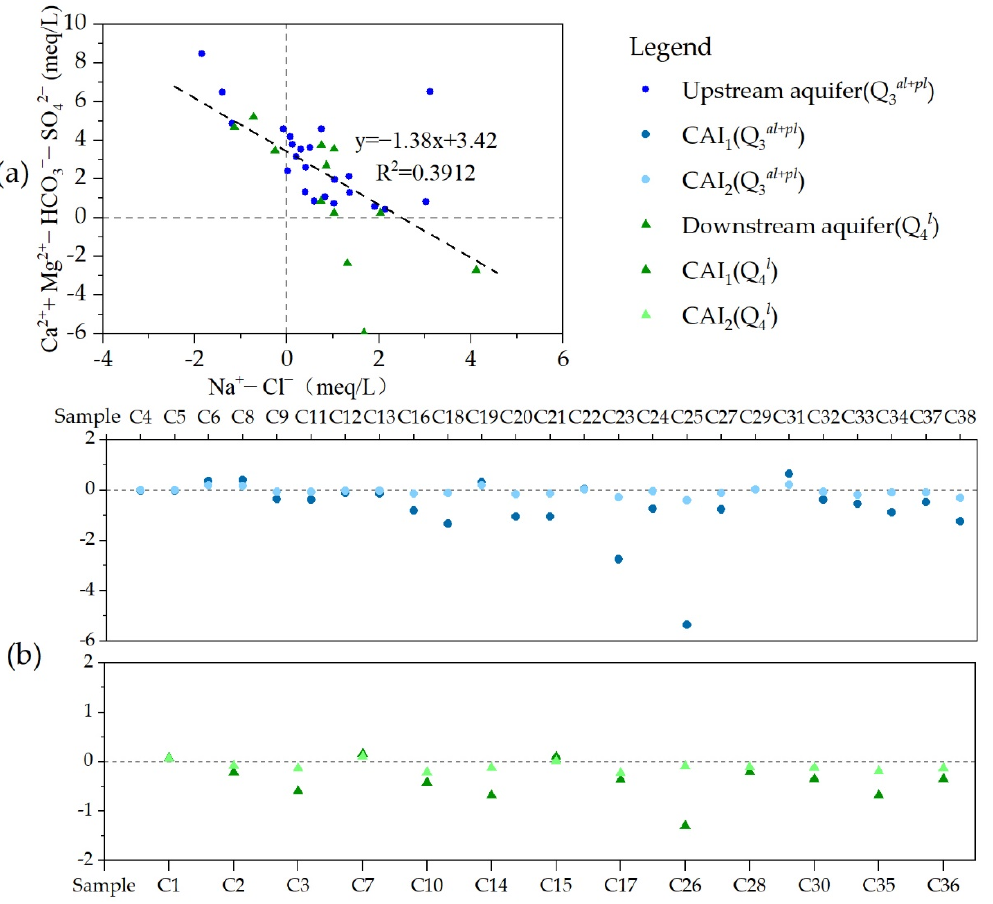
Figure 7. Coefficient diagrams of (Na + − Cl − ) vs. (Ca 2+ + Mg 2+ − SO 42 − − HCO 3 − ) for analyzing cation exchange reaction ( a ) and distribution diagram of Chloro–alkaline indices ( b ).